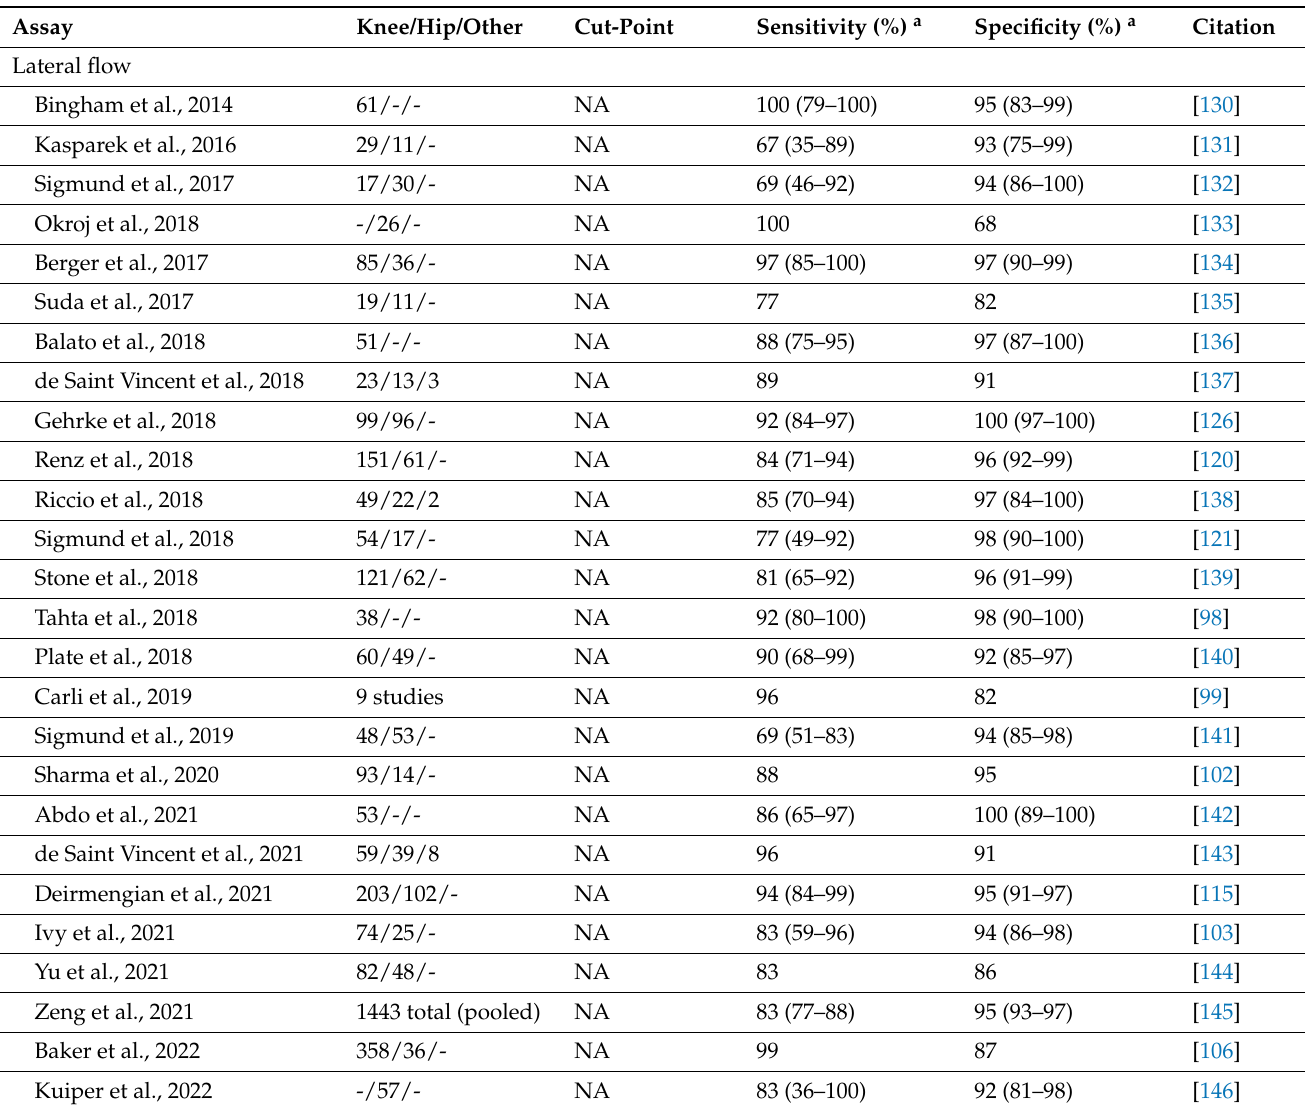
Table 2. Sensitivity and specificity of synovial fluid α -defensin for periprosthetic joint infection